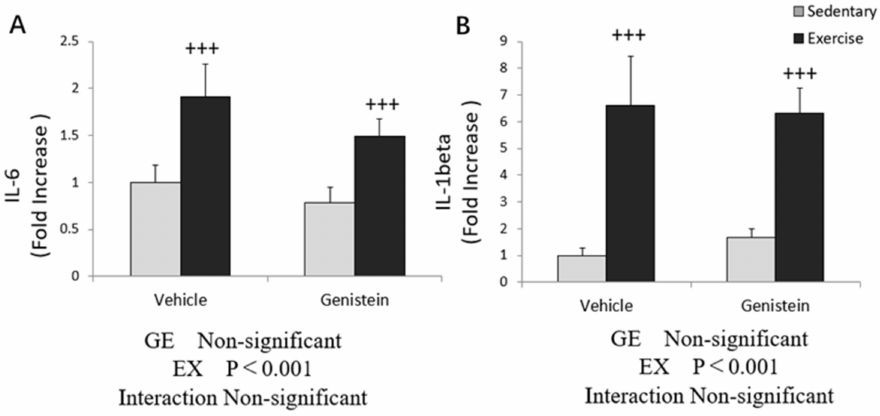
Figure 7. ( A ) IL-6 mRNA (Con, n = 7; GE, n = 7; Ex, n = 7; GE+EX, n = 7); ( B ) IL-1 β mRNA (Con, n = 8; GE, n = 7; Ex, n = 6; GE+EX, n = 7), vehicle: non-supplemented groups (only administrated with 0.5% CMC-Na solution); GE: GE-supplemented groups. +++ p < 0.001, the main effect of exercise. Values are means ± SE.